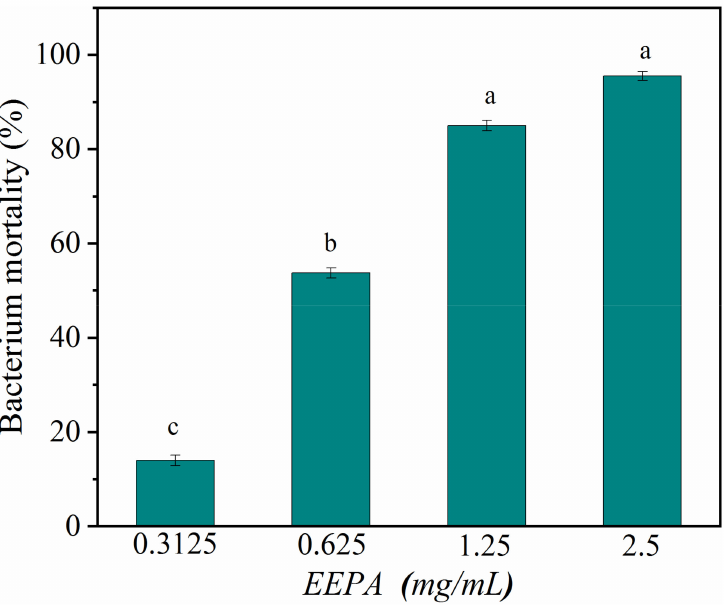
Figure 4. Bacterium mortality of S. aureus after treatment with EEPA at concentrations of 0.3125–2.5 mg · mL − 1 . Different lowercase letters indicate a significant difference in bacterium mortal- ity at different concentrations, according to Duncan’s multiple range test ( p < 0.05).